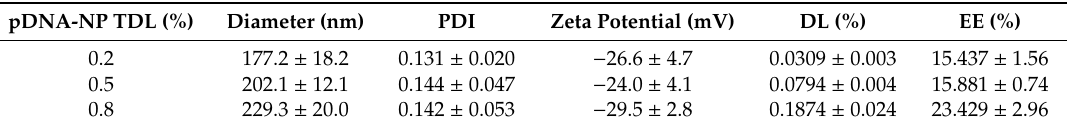
Table 1. Characteristics of pDNA-NP as a function of theoretical pVAX1-NH36 loadings (pVAX1-NH36 TDL). Data represent mean ± SD ( n = 3).